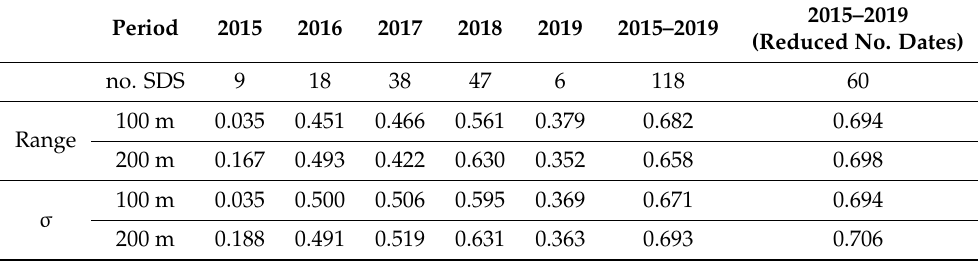
Table 2. The statistical relationship between grain size and shoreline variability according to Ec. 1. The goodness of fit is expressed as coefficient of determination R2. Columns show the correlation values for different periods. The column on the right only considers SDS associated with the 30 highest and the 30 lowest sea-level registers (about half of the available SDS for the whole period).